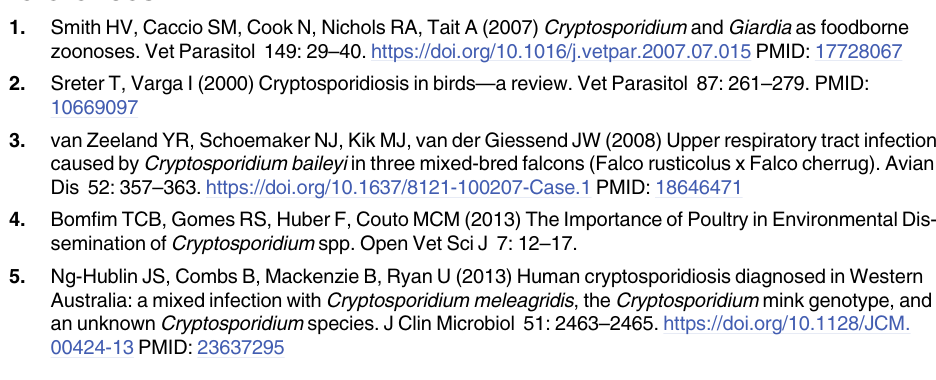
S1 Table. Raw data for all poultry farms included in the